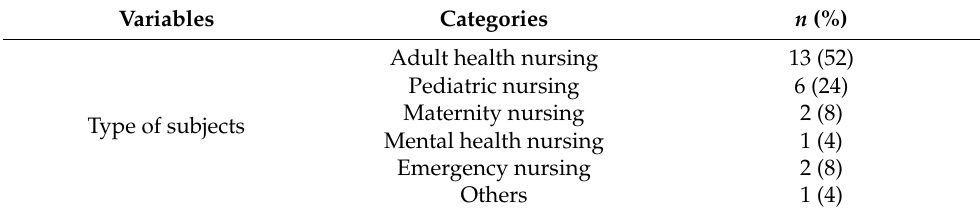
Table 4. Analysis results classified by the simulation subject courses ( n =